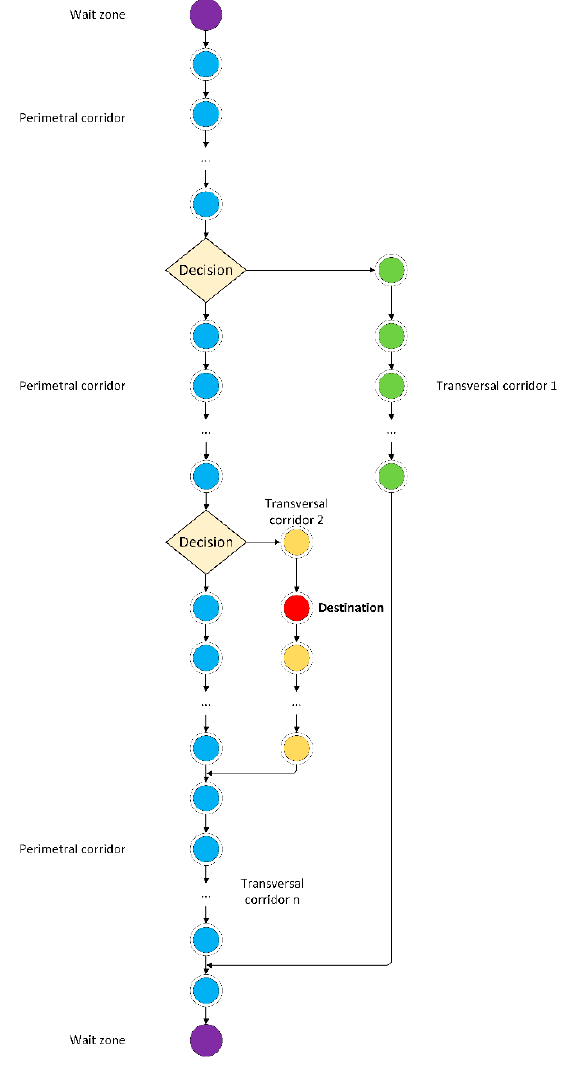
Figure 6. Mapping RFID tags as nodes.